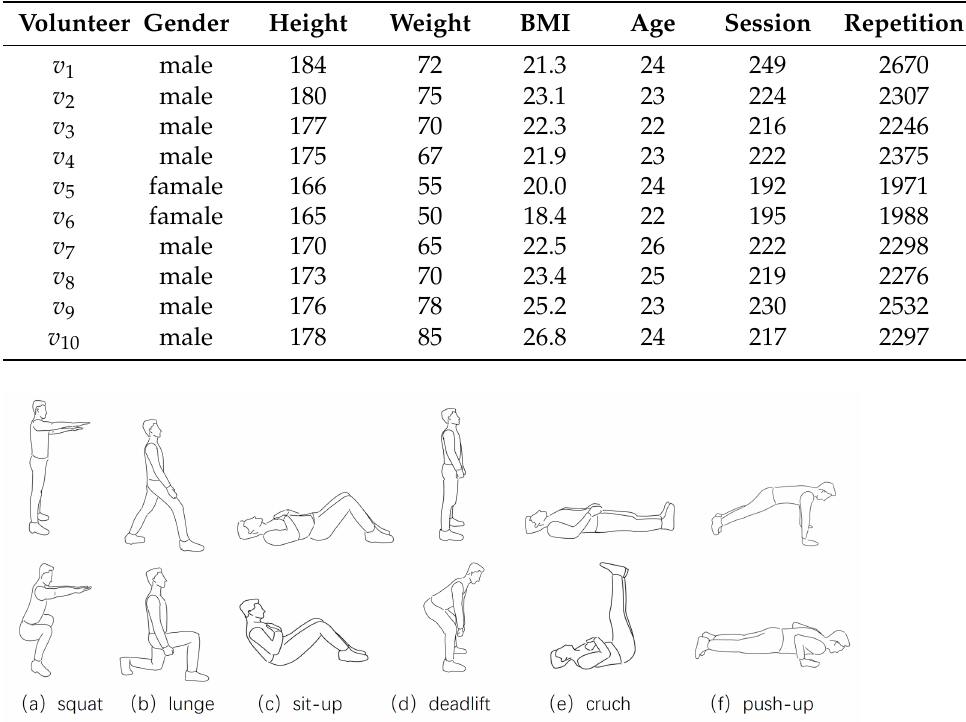
Table 1. Detailed parameters for ten volunteers [15].